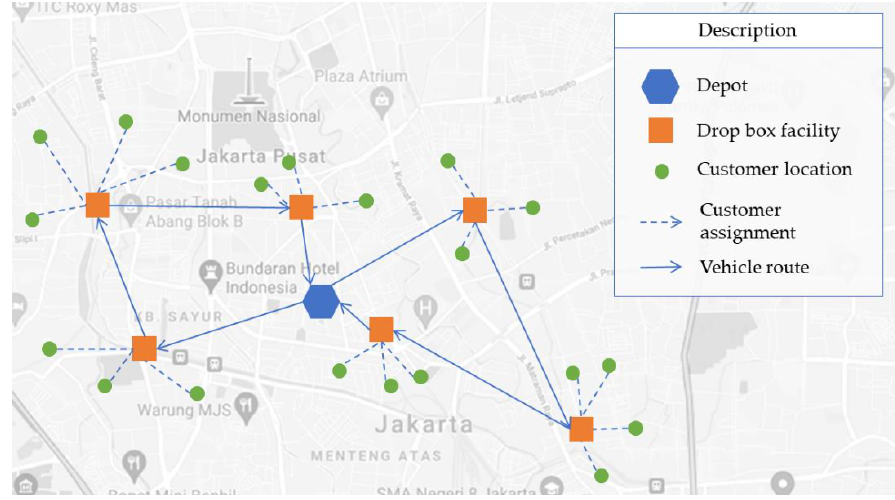
Figure 1. Illustration of reverse logistics using drop box facilities.